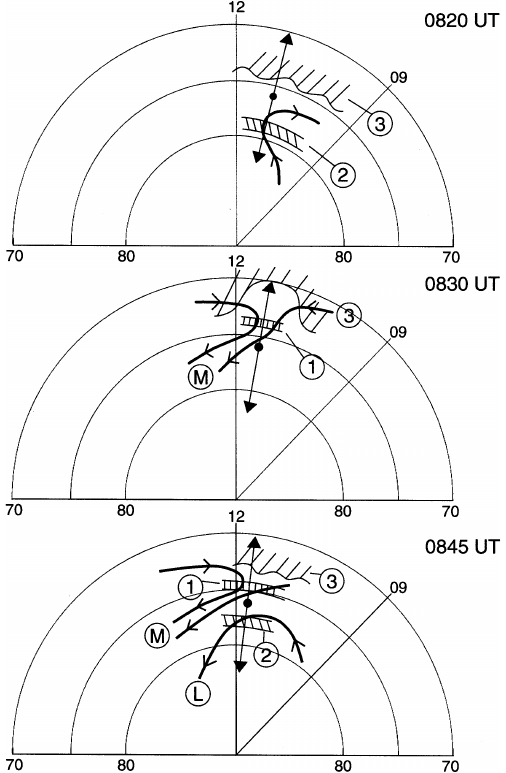
Fig. 5. Schematic illustration of plasma convection and au- rora in MLAT-MLT coordinates for 08:20–08:25UT (upper panel), 08:30UT (middle panel), and 08:45UT (lower panel). Different categories of auroral forms are labelled 1 and 2 (cusp types), and 3 (plasma sheet aurora). Plasma convection belonging to merging and lobe convection cells are marked M and L , respectively. The field-of-view of the meridian scanning photometer in Ny ˚Alesund (optical site; marked by solid dot) is indicated by double-arrowed meridional